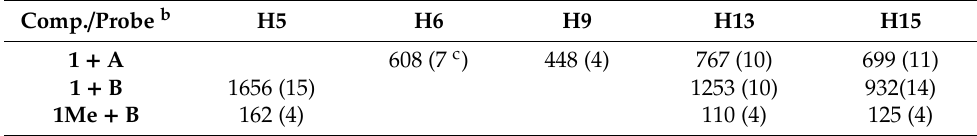
Table 1. The association constants a (M − 1 ) for 1 + A , 1 + B and 1Me + B complexes.